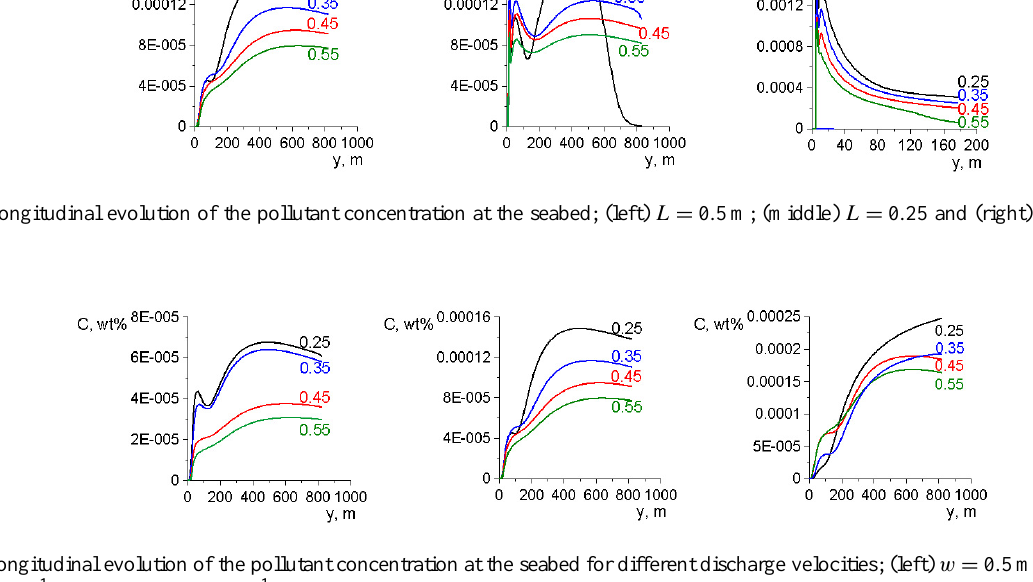
Fig. 13. Longitudinal evolution of the pollutant concentration at the seabed for different discharge velocities; (left) w = 0 . 5ms − 1 ; (middle) w = 1 . 35ms − 1 and (right) w = 3ms − 1